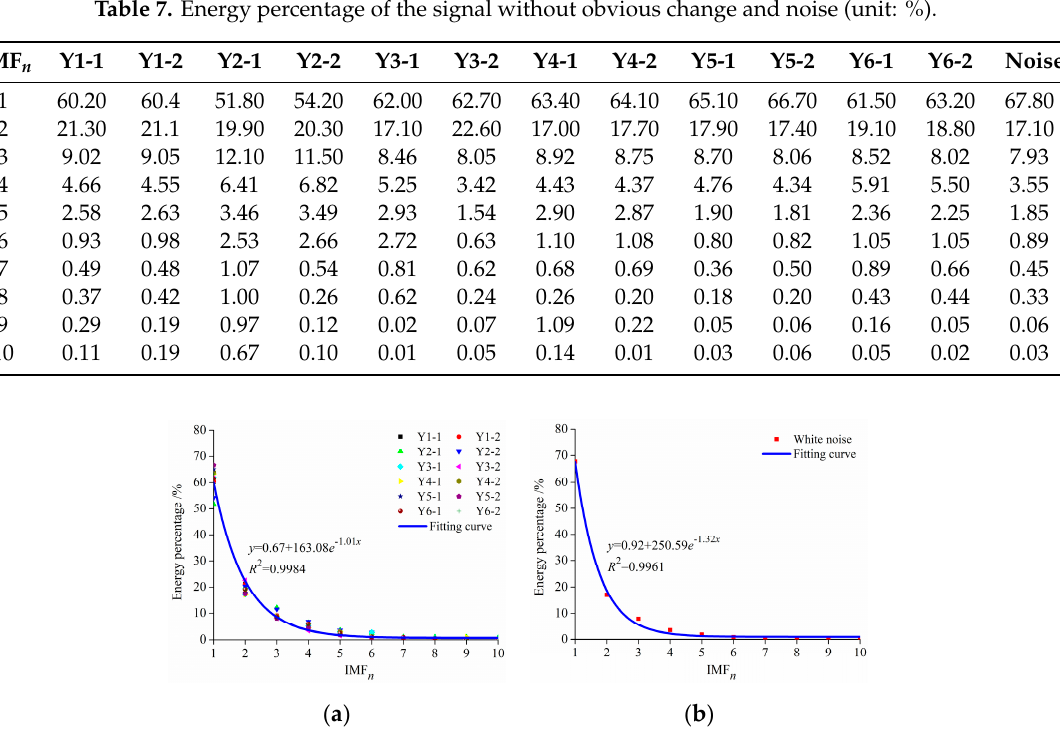
Table 7. Energy percentage of the signal without obvious change and noise (unit: %).